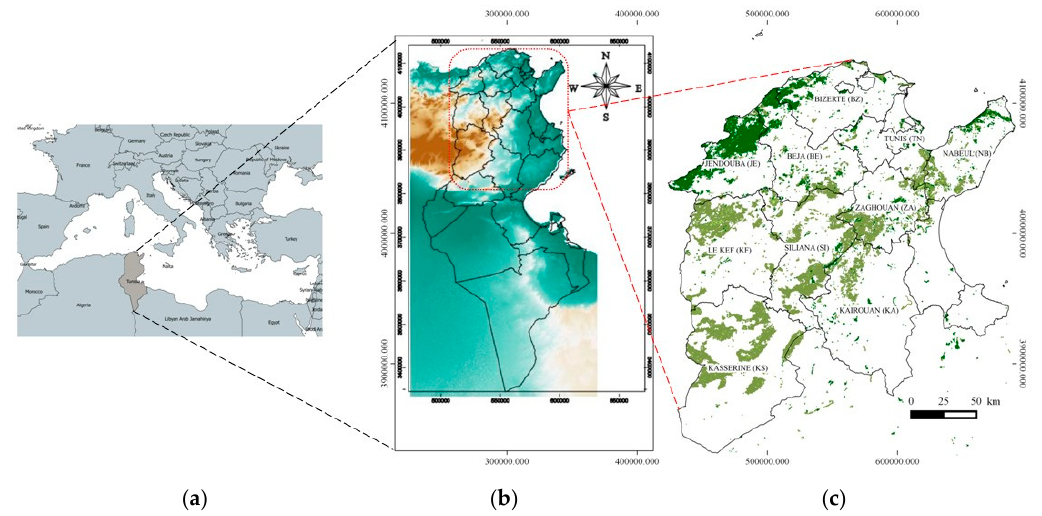
Figure 1. Location of Tunisia within the Mediterranean basin ( a ); with the map of altitudes ( b ); and, administrative units overlayed with forest/shrubland distribution ( c ).